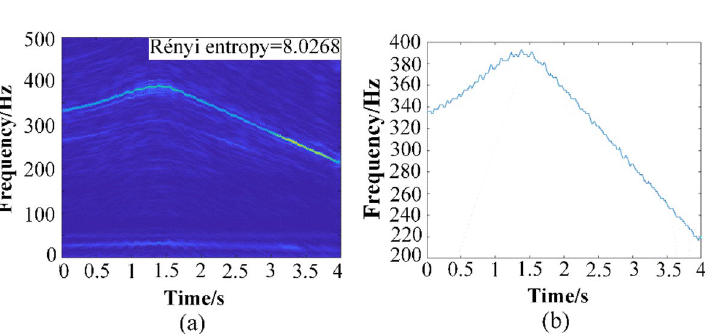
Figure 10. ( a ) The time domain spectrum ( b ) The frequency domain spectrum ( c ) motor speed.